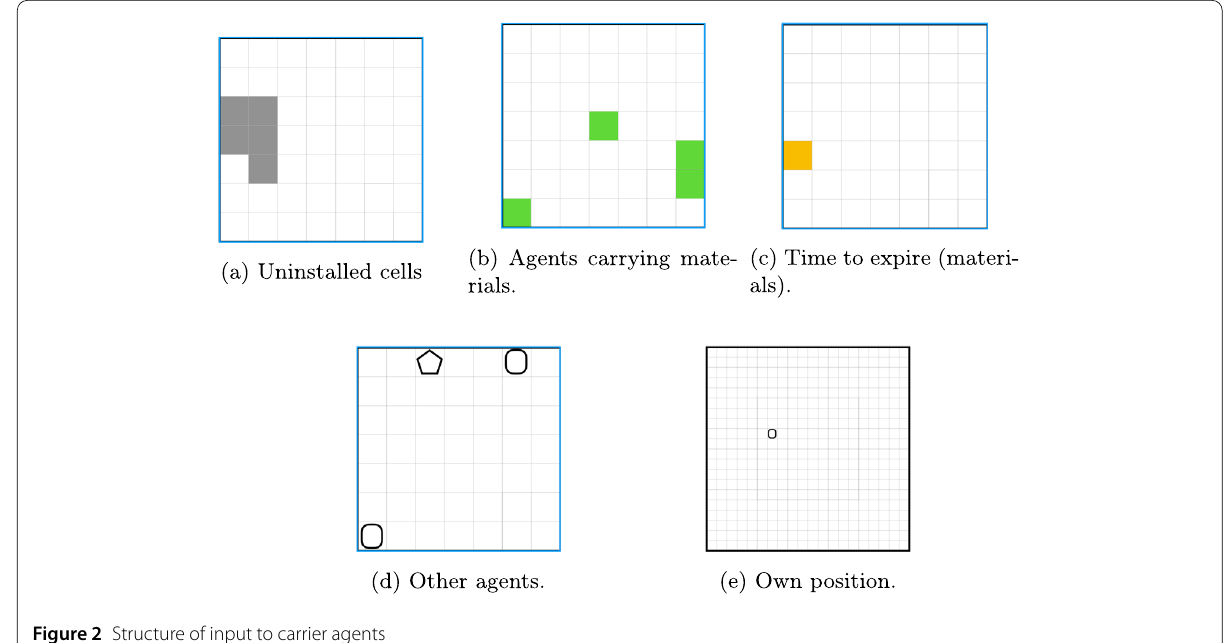
Figure 2 Structure of input to carrier agents